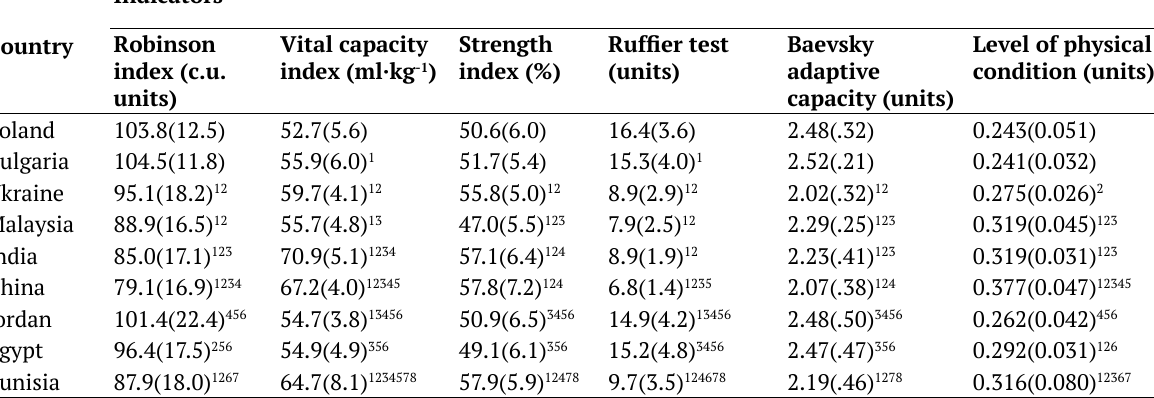
Table 3. Indicators of express assessment of students’ somatic health,